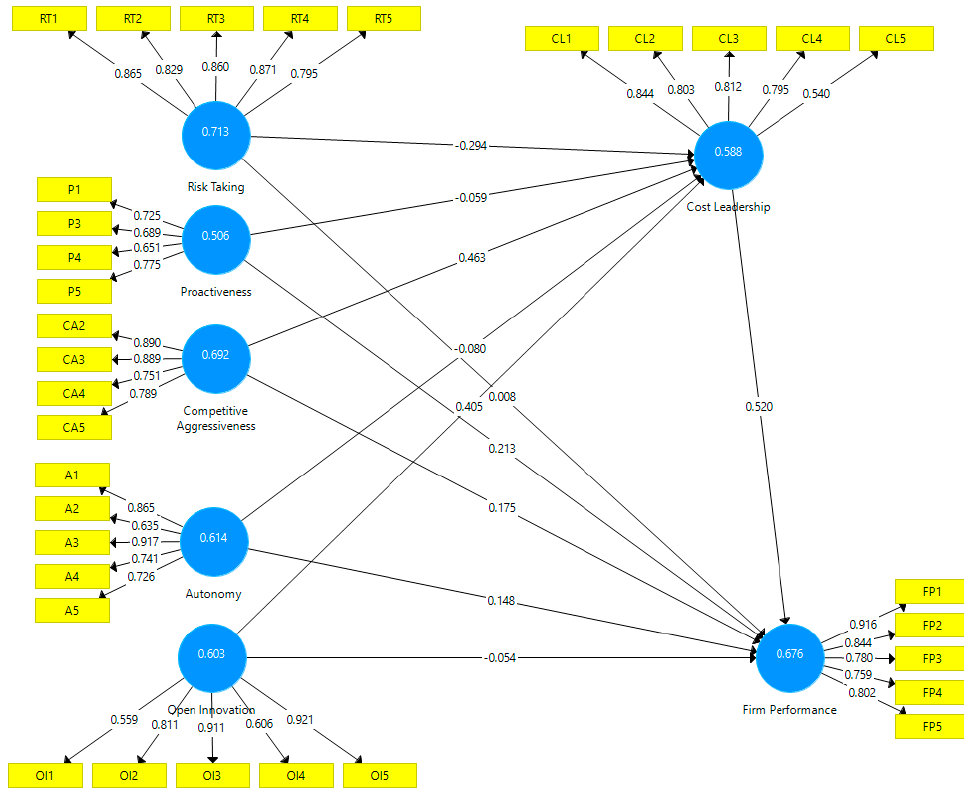
Figure 2. Measurement Model.